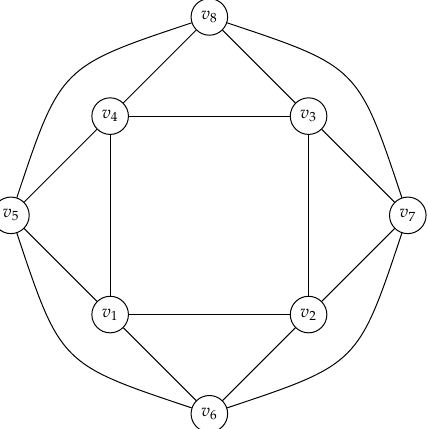
( G ) = 4, γ g ( G ) = 6 and γ g 2 t 1 t